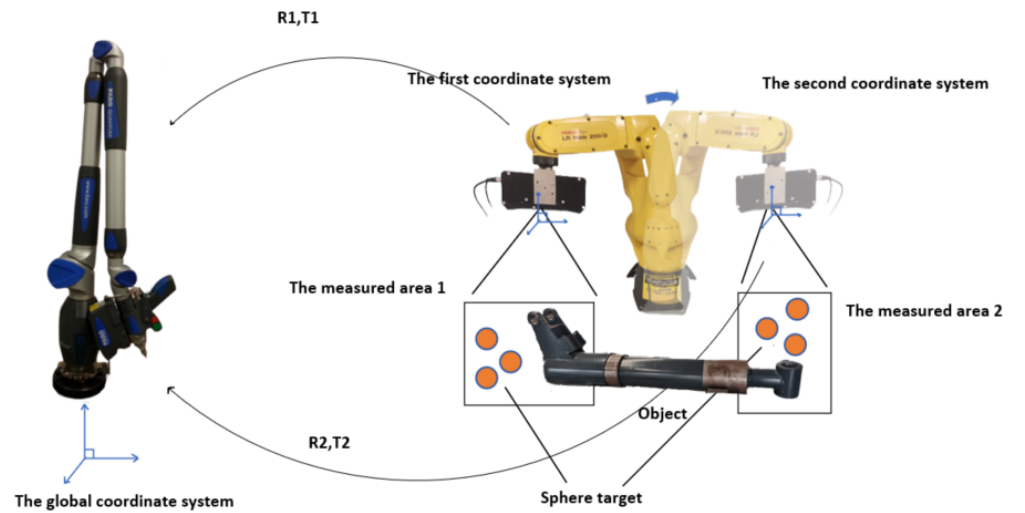
Figure 1. Diagram of combined measurement system.